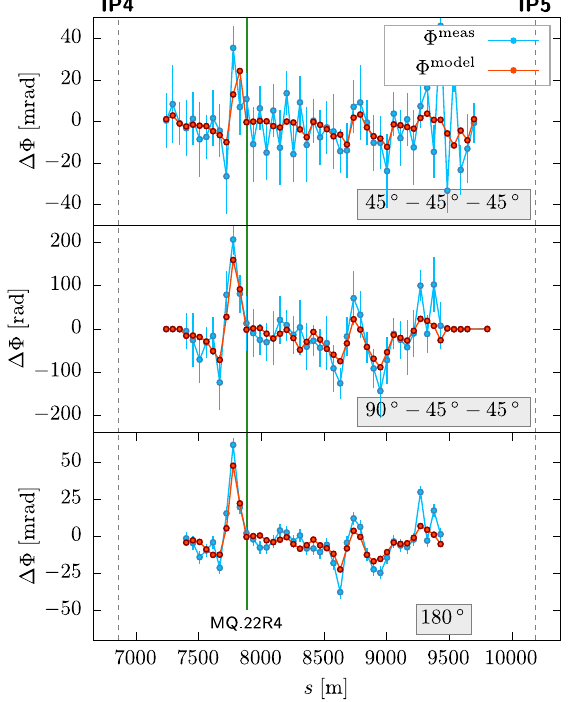
FIG. 7. Similar plots as in Fig. 6 but including a phase error of 0 . 7 × 10 − 3 × 2 π rad for high β function values and 1 . 8 × 10 − 3 × 2 π rad for low β s. The agreement between model and simulation and measurement is highly deteriorated. The error bars have been calculated using Eqs. (9) and (11). The case φ m ij ¼ π is affected less by the error since only one phase advance error is propagated.